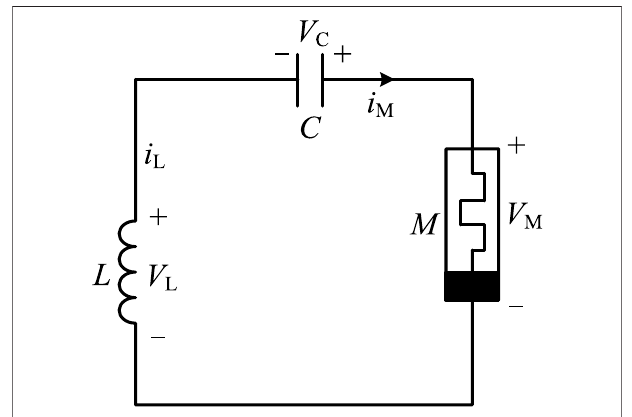
FIGURE 3 | The simplest memristor chaotic circuit.